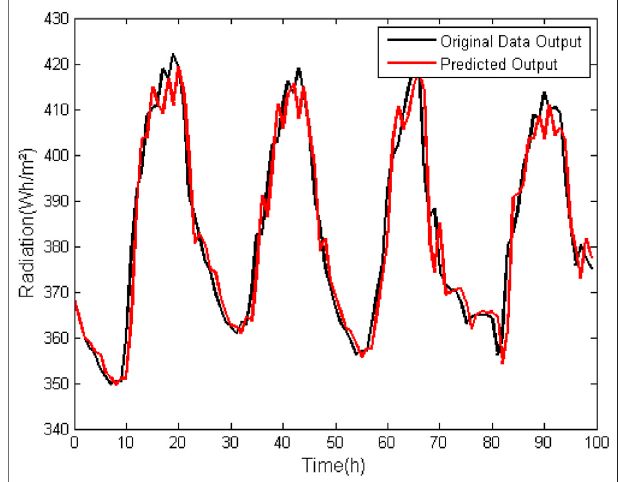
FIGURE3| ARXmodel(na=3,nb=3,nk=1)forpredictionofhorizontal infrared horizontal radiation data without suppression of